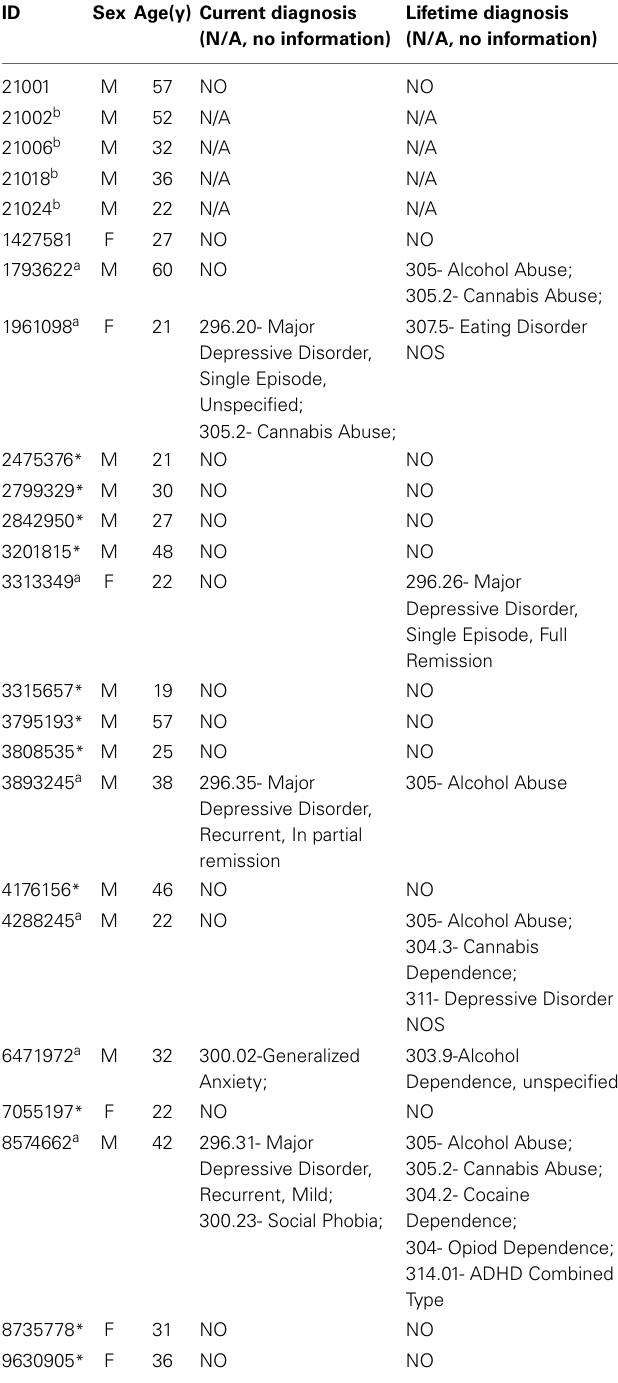
Table 1 | Summary of phenotype information of